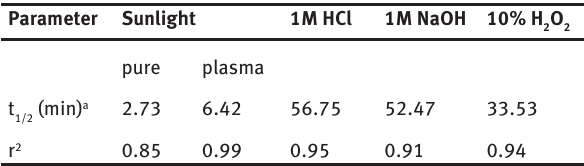
Table 4: Results of the degradation study of DCV under different stress